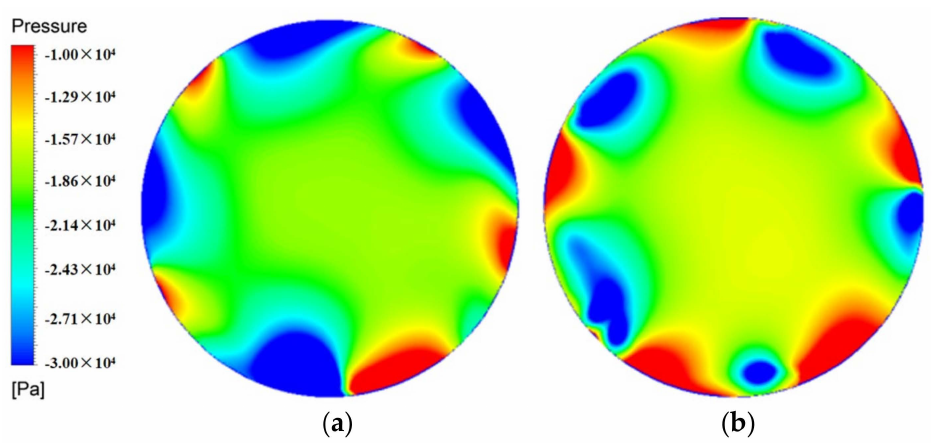
Figure 11. Blade inlet section of 5-blades pump of ( a ) scheme 11 and ( b ) scheme 25.